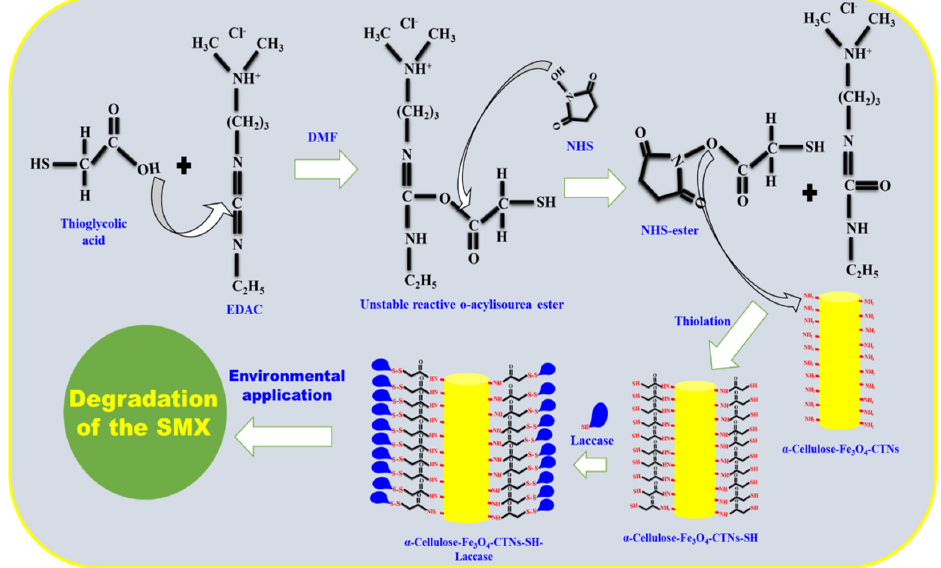
Figure 1. Schematic presentation of a chemical scheme for laccase immobilization on α -Cellulose- Fe 3 O 4 -CTNs-SH and its environmental